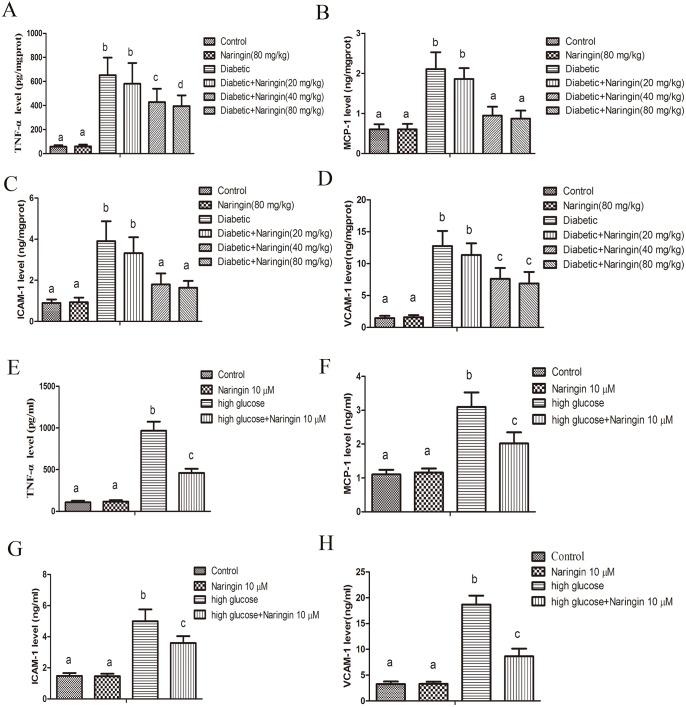
Naringin inhibited inflammatory reaction in kidney tissues and HBZY-1 cells.The TNF-α(A), MCP-1(B), ICAM-1(C) and VCAM-1(D) levels in kidney tissues were determined by ELISA assay. Data were expressed as means ± SD, n = 6. The TNF-α(E), MCP-1(F), ICAM-1(G) and VCAM-1(H) levels in HBZY-1 cells were determined by ELISA assay. Data were expressed as means ± SD, n = 3.a-d Means with different superscripts are significantly different (P< 0.05).